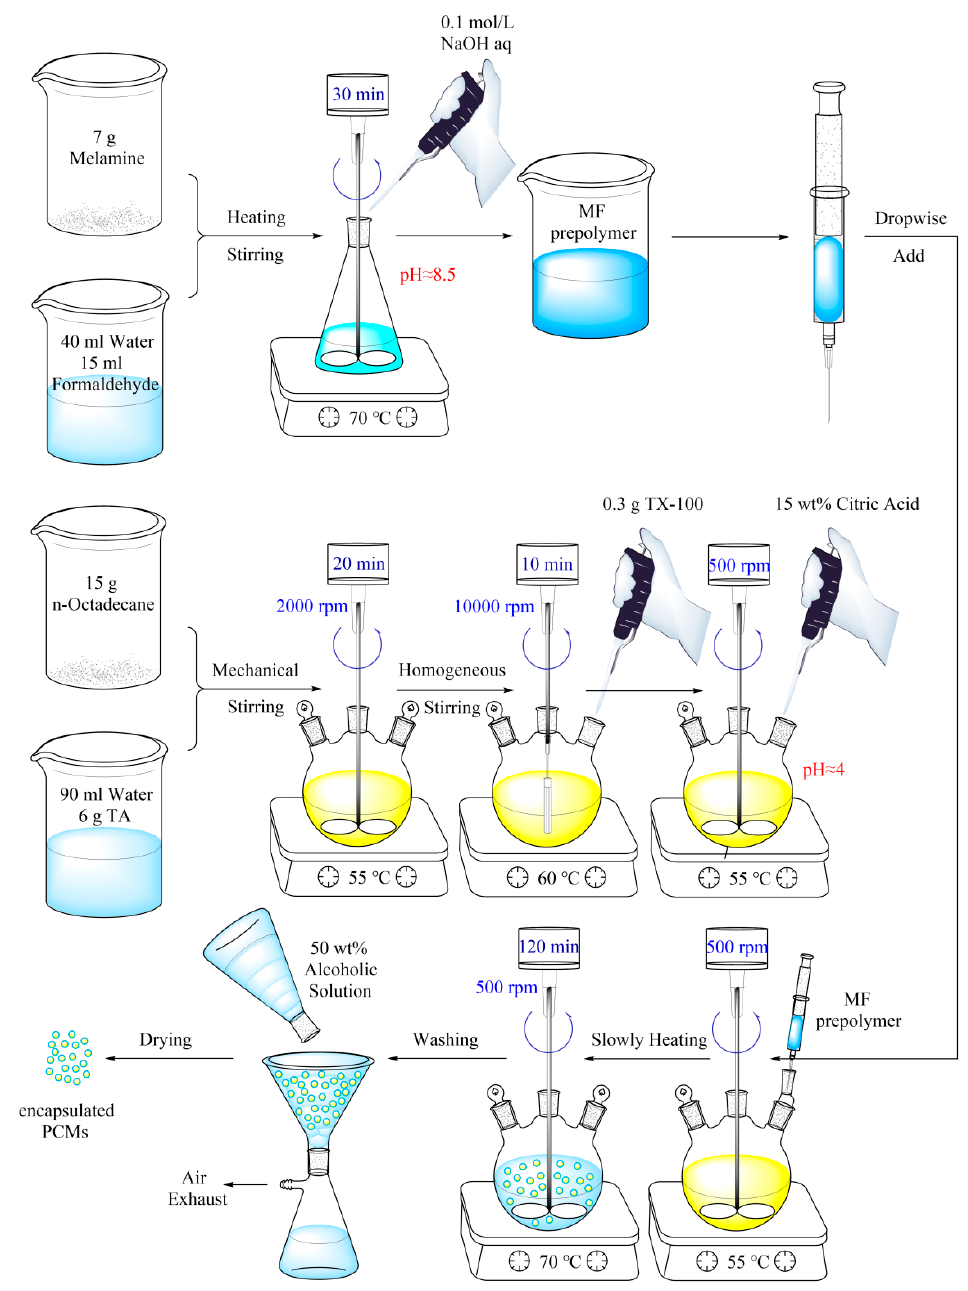
Figure 3. Fabrication schematic diagram of encapsulated n -octadecane with the MF resin shell.